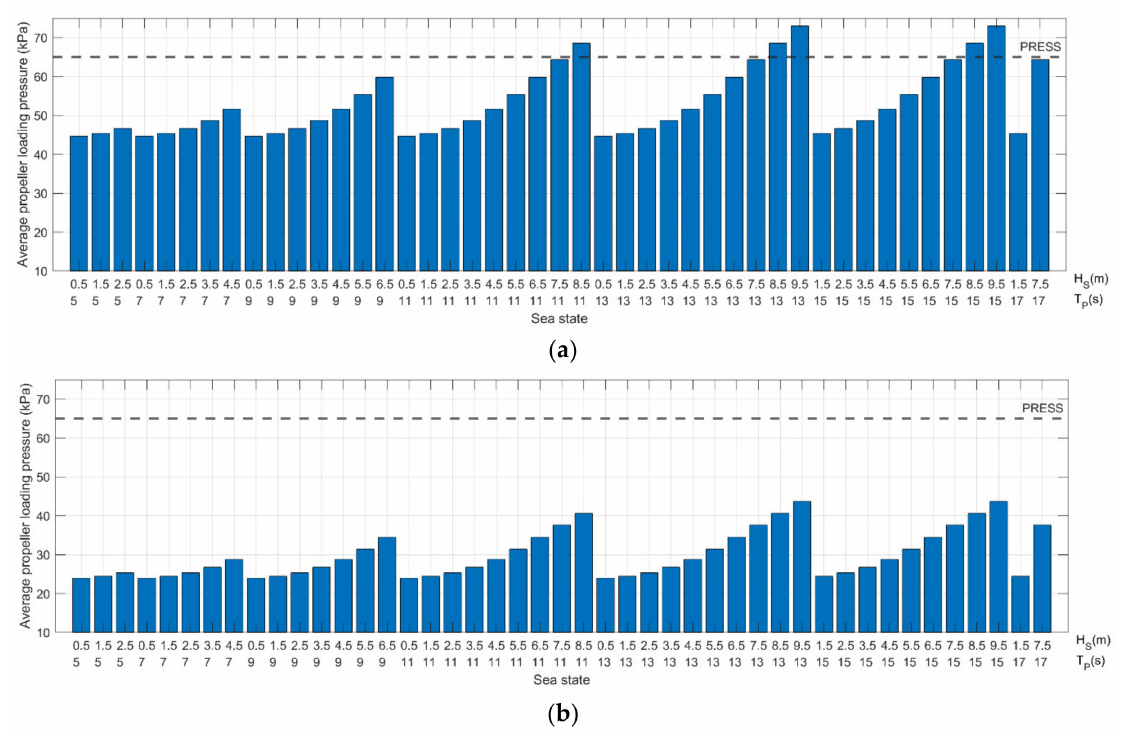
Figure 9. Variation of average propeller loading pressure for different sea states. ( a ) no cup,